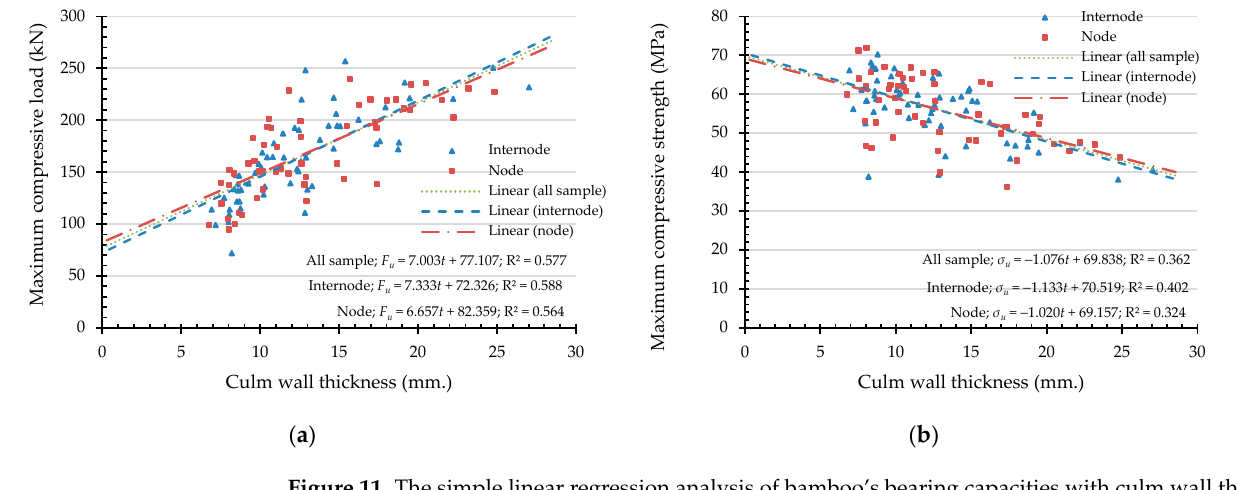
Figure 11. The simple linear regression analysis of bamboo’s bearing capacities with culm wall thickness as an indicating property: ( a ) maximum compressive load ( u F ) and ( b ) maximum compressive strength ( u σ ).